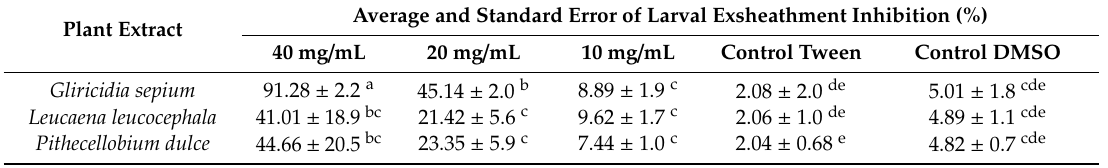
Table 2. Comparison of the effect of the three forage species on larval exsheathment inhibition in vitro. Plant